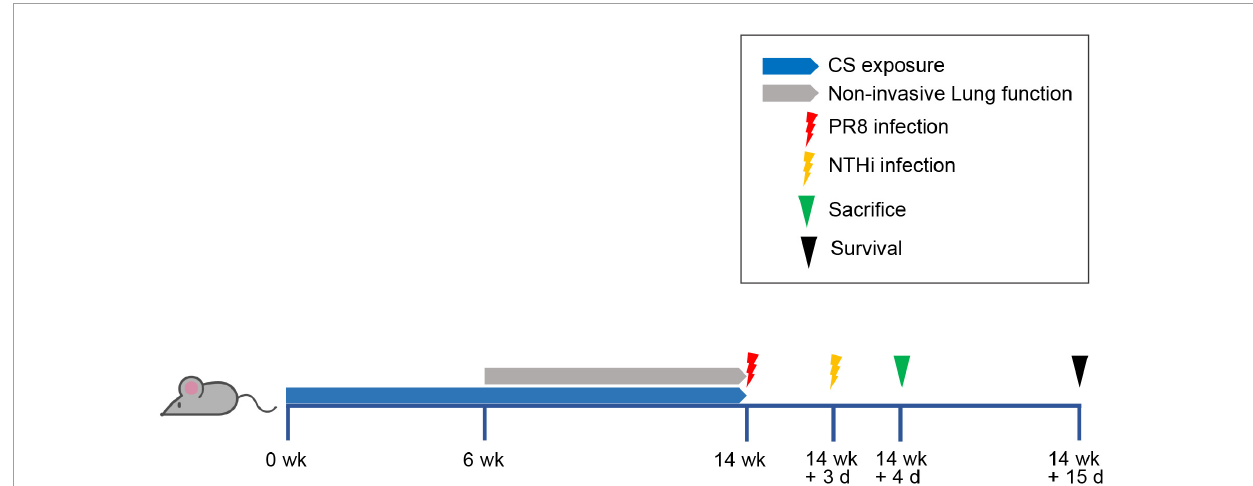
FIGURE1 Experimental flow chart. Mice were exposed to one cigarette per day for 14 weeks and then intranasally inoculated with non-lethal dose of PR8 or PBS. At 3 days post-infection (dpi), mice were challenged with NTHi or PBS. After detecting invasive lung function at 24 h post-NTHi challenge, mice were sacrificed and samples were collected for further analysis, including histopathology, lung index, replication of pathogens, inflammatory mediators, immune cells, and gut microbiota. Survival rate was calculated at day 15 after PR8 infection.